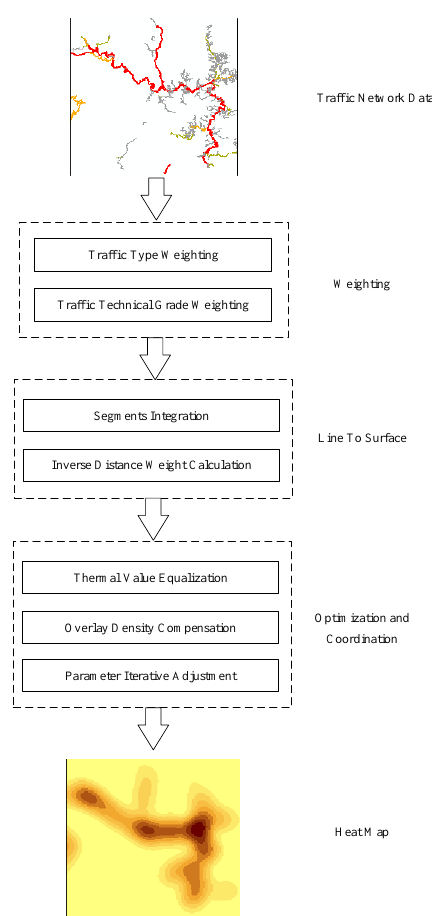
Figure 1. Thermal calculation